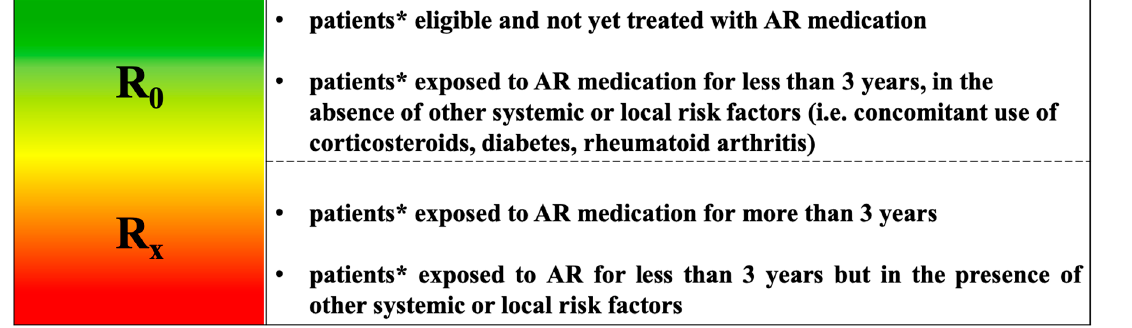
Figure 1. MRONJ risk profile of patients with metabolic bone fragility receiving AR medications [19]